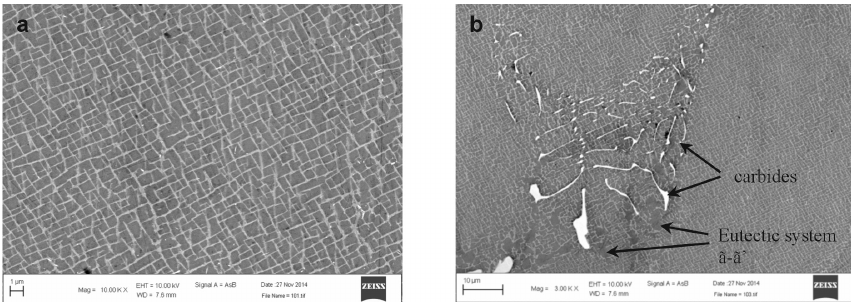
Fig. 3. The microstructure of blade No. 1, cross-section at the locking: a) γ’ phase particles separated by γ phase matrix channels, b) inter-dendritic area, γ–γ’ eutectic system, carbides particles with the "Chinese-script" morphology, SEM